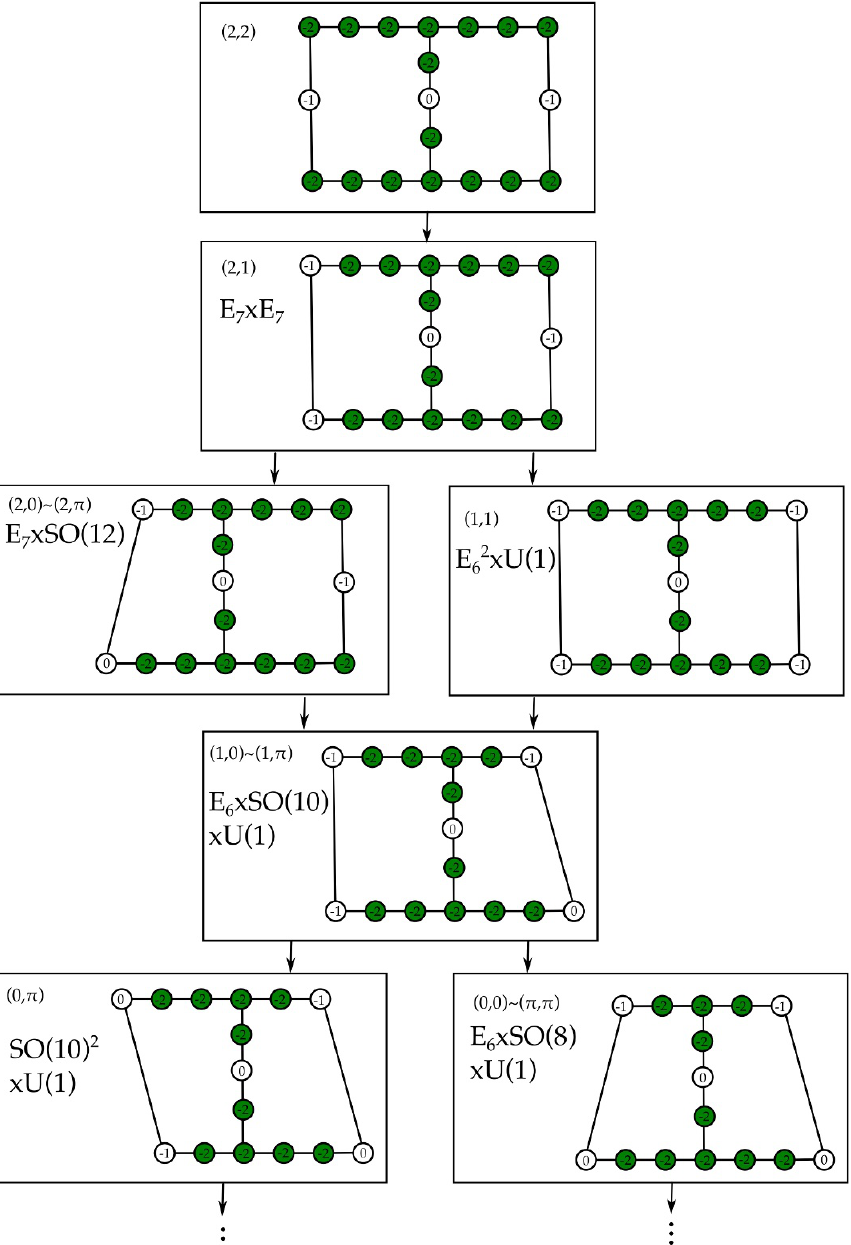
Figure 17 . Subtree of the (E 7 ; E 7 ) CFD-tree of theories that have a quiver description. The full CFD-tree can be seen in [89] and has 56 descendants. The theories that have a known quiver description, and comprise a small subset, are shown